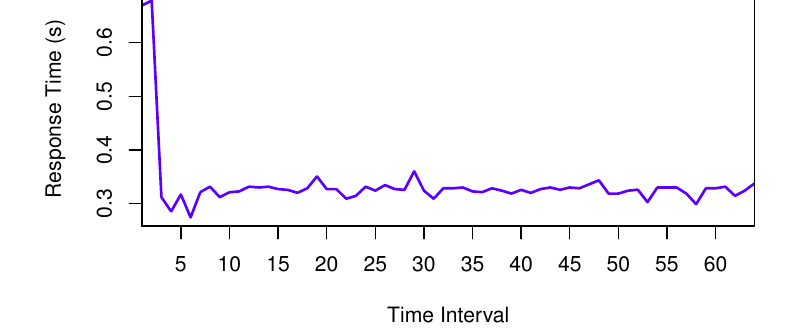
Figure 5. QoS Series.